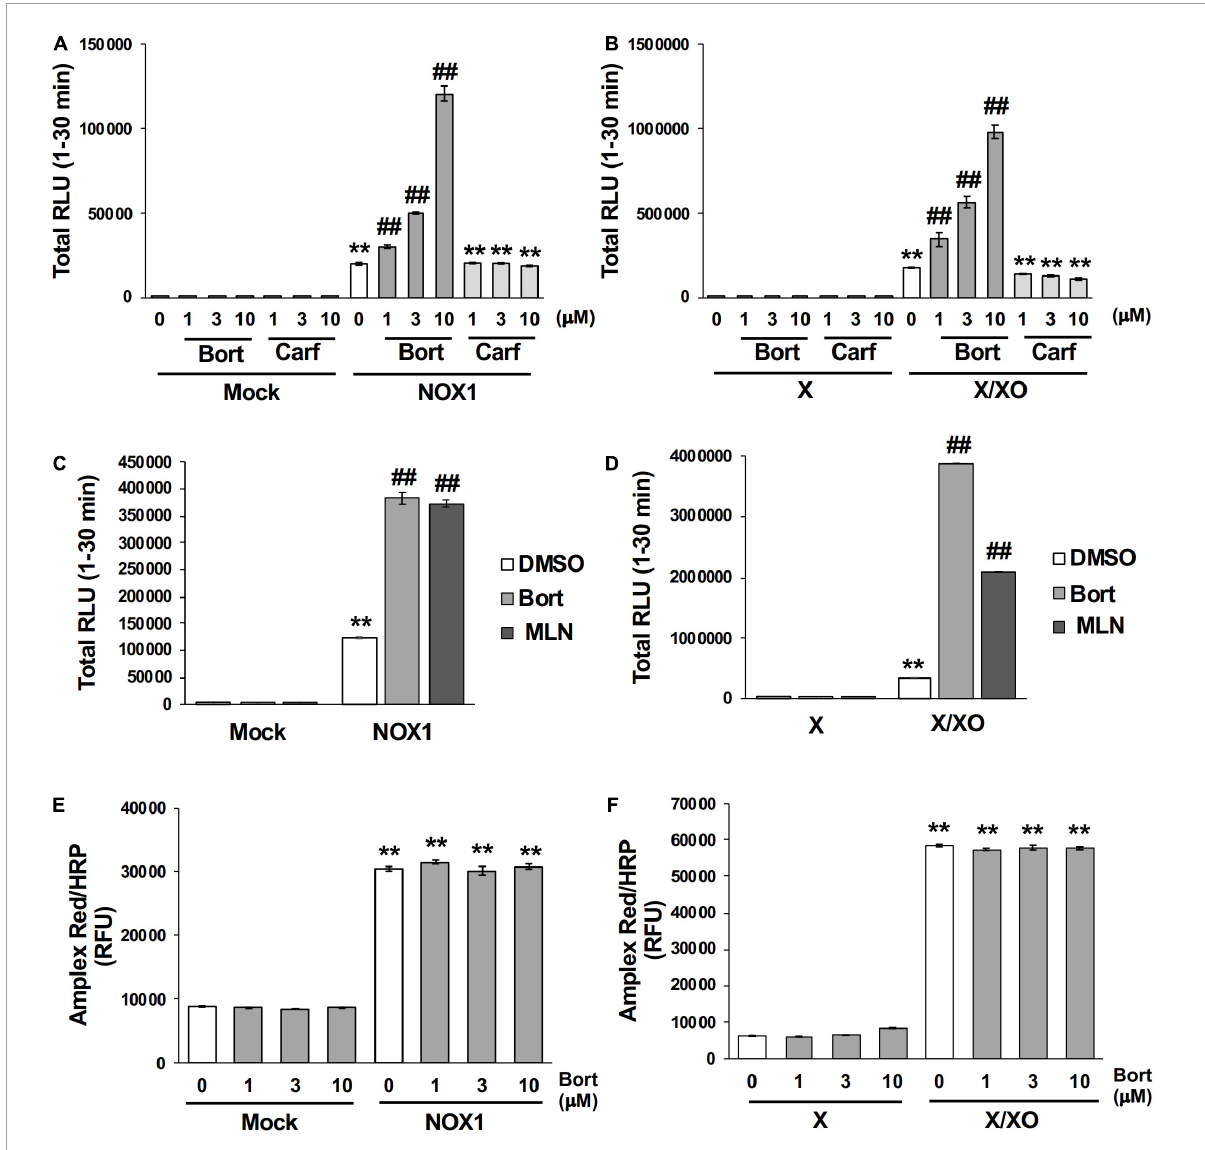
FIGURE4 Bortezomib-induced enhancements in L-012 luminescence were dependent on chemical structure of the peptide boronic acid and specific to the detection of superoxide. Effects of bortezomib (Bort) or carfilzomib (Carf) on total L-012 luminescence during the 30 min measurement in NOX1-expressing cells [ (A) , 1 × 10 5 cells/0.1 ml] and the X/XO system [ (B) , 0.2 mM X and 5 mU/ml XO]. The effects of bortezomib or MLN2238 (MLN, 10 µ M) on L-012 luminescence in NOX1-expressing cells (C) and the X/XO system (D) . Effects of bortezomib on the Amplex Red/HRP-dependent detection of H 2 O 2 in NOX1-expressing cells (E) and the X/XO system (F) . The fluorescence of Amplex Red/HRP was expressed as relative fluorescence units (RFU). N = 3. Data were from two independent experiments, and expressed as the mean ± SEM. ∗∗ P < 0.01 versus the control (Mock or X). ## P < 0.01 versus 0 µ